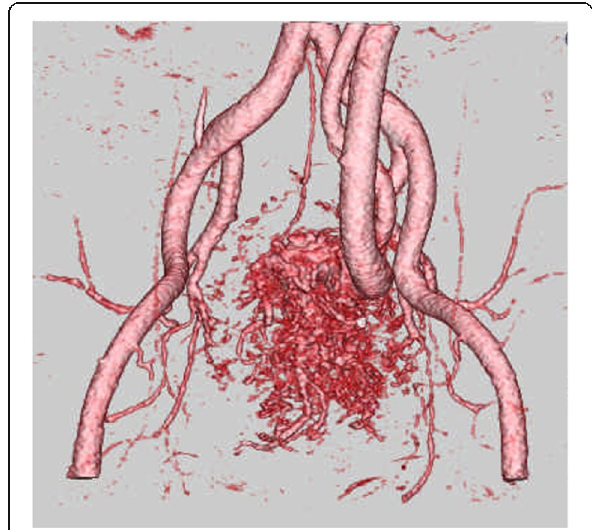
Fig. 3 Four-dimensional CT angiography demonstrated that